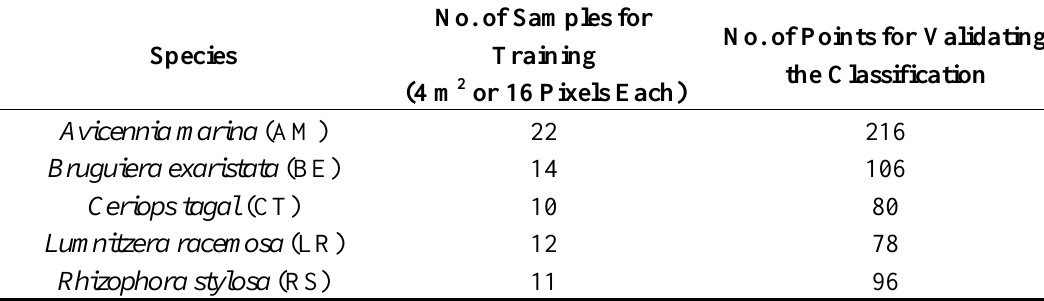
Table 2. Number of samples (4 m 2 each) used for training and number of sample points generated for validation for each mangrove